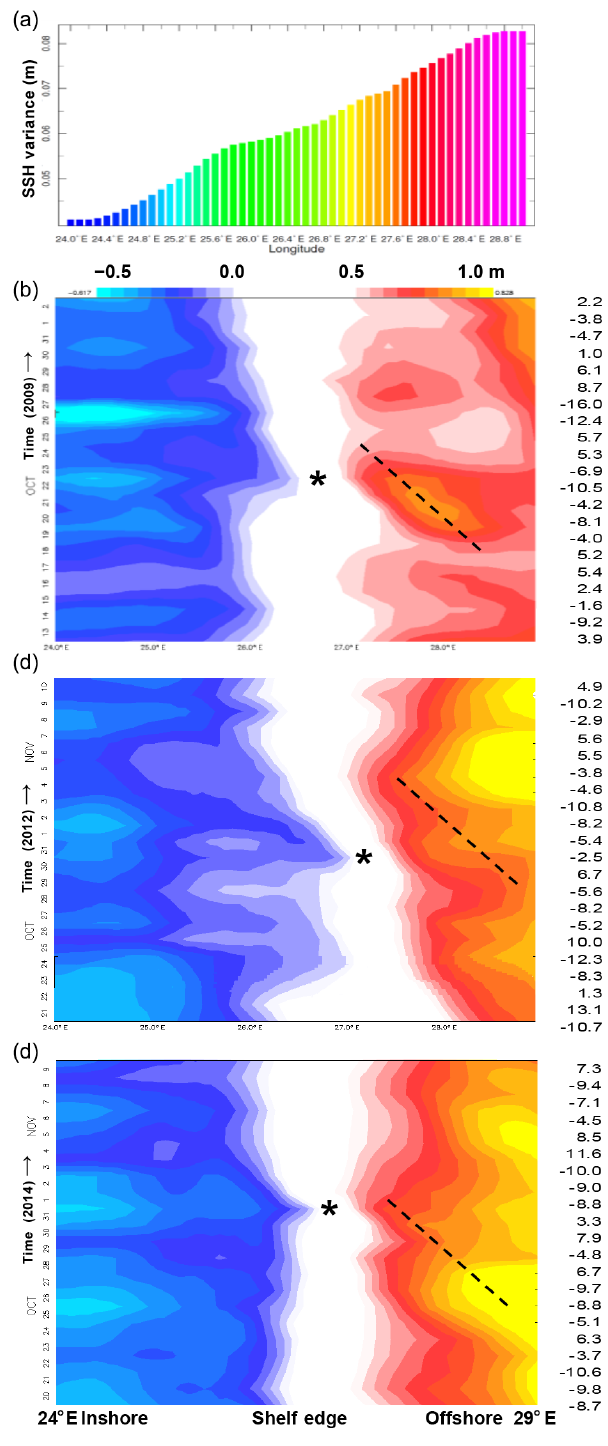
Figure A2. (a) Variance (root mean square) of sea surface height anomalies on 34.5 ◦ S per 0.1 ◦ longitude, 2006–2017. Hovmöller plots of HYCOM daily sea surface height on 34.5 ◦ S over 20d dur- ing three early summer chlorophyll fluorescence events: (b) 2009, (c) 2012, and (d) 2014. Asterisk highlights steepest SSH gradient; dashed lines highlight ∼ 0 . 2ms − 1 westward movement of anticy- clonic warm rings in the offshore zone. Numbers in the right column are index-area daily zonal winds (ms − 1 , − U from